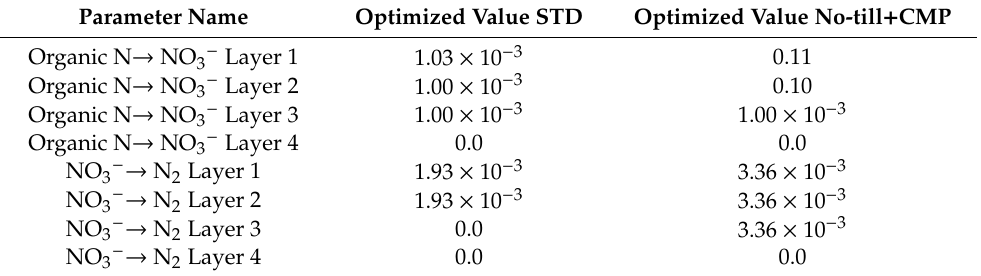
Table 6. N mineralization rates and denitrification rates (1 / day) obtained by inverse modelling in the STD and No-till + CMP experimental